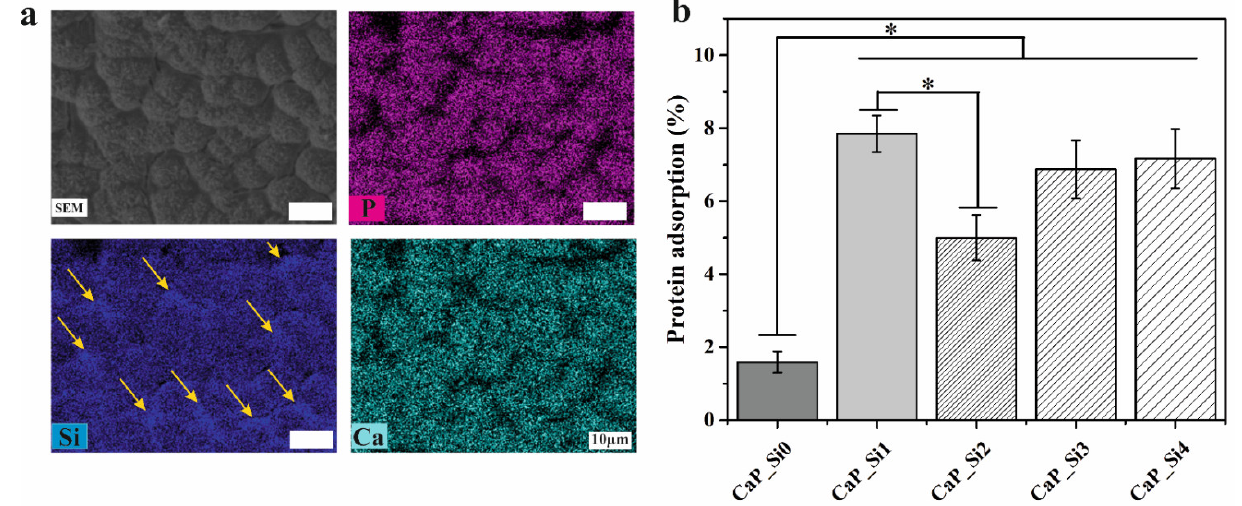
Figure 4. ( a ) EDS elemental mapping of phosphorus (P), silicon (Si) and calcium (Ca) of the sample CaP_Si4. Scale bar: 10 μm. ( b ) The protein adsorption (%) of BSA CaP_Si powders. Silicon between globules is depicted by yellow arrows. The significant difference between the two groups (*): p < 0.05.